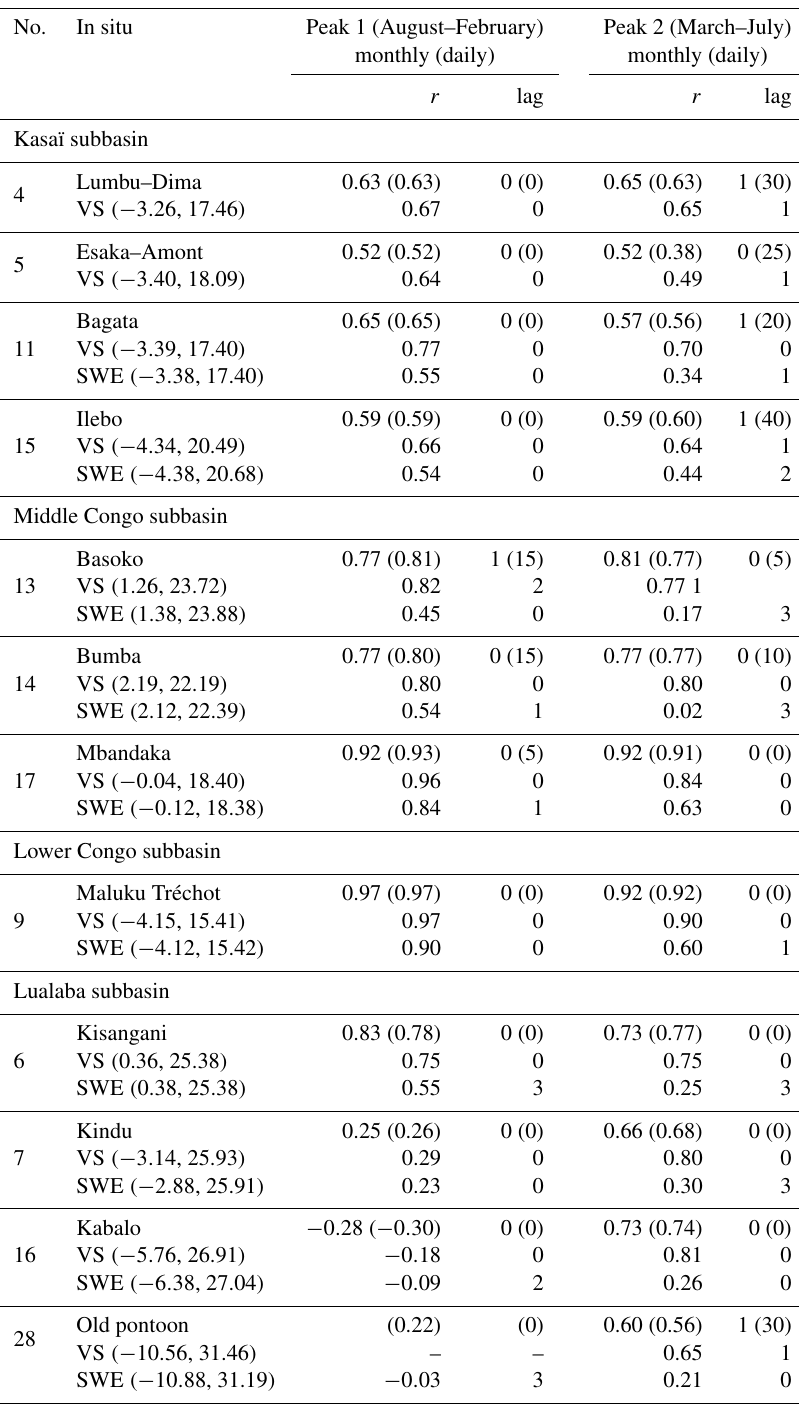
Table 4. Optimal coefficient correlation and associated lag for each in situ station against SWH and discharge at the Brazzaville/Kinshasa station for the two periods of time corresponding to the first and second peak and for their closest VS and GIEMS-2 cell (SWE). Their latitude and longitude are in parentheses in the second column. In parenthesis, in the last two columns, the r and lag values, using daily observations are shown. Only correlations with a 95% significance are